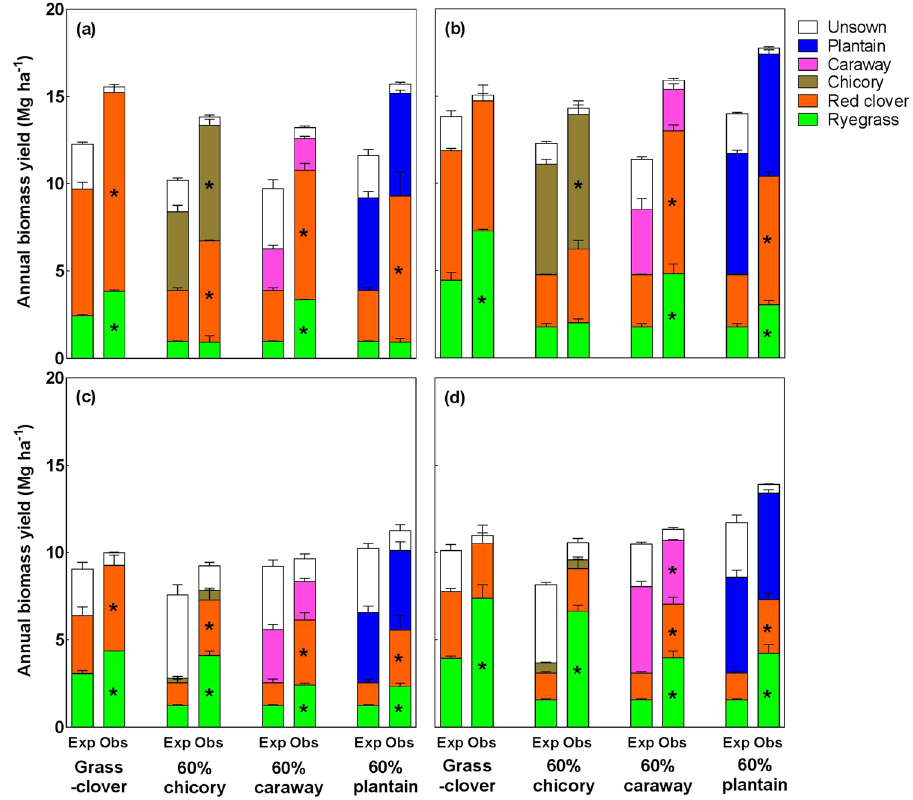
Figure 3. Annual biomass yield as observed (Obs) and expected (Exp) in the four seed mixtures in 2014 ( a , b ) and 2015 ( c , d ) without ( a , c ) and with ( b , d ) fertilisation. The expected values are calculated as the weighted mean biomass yield in pure stands in the respective year. Data are means ± SE ( n = 3) for each component species. Asterisks refer to significant differences ( P < 0.05) between expected and observed yield for each component